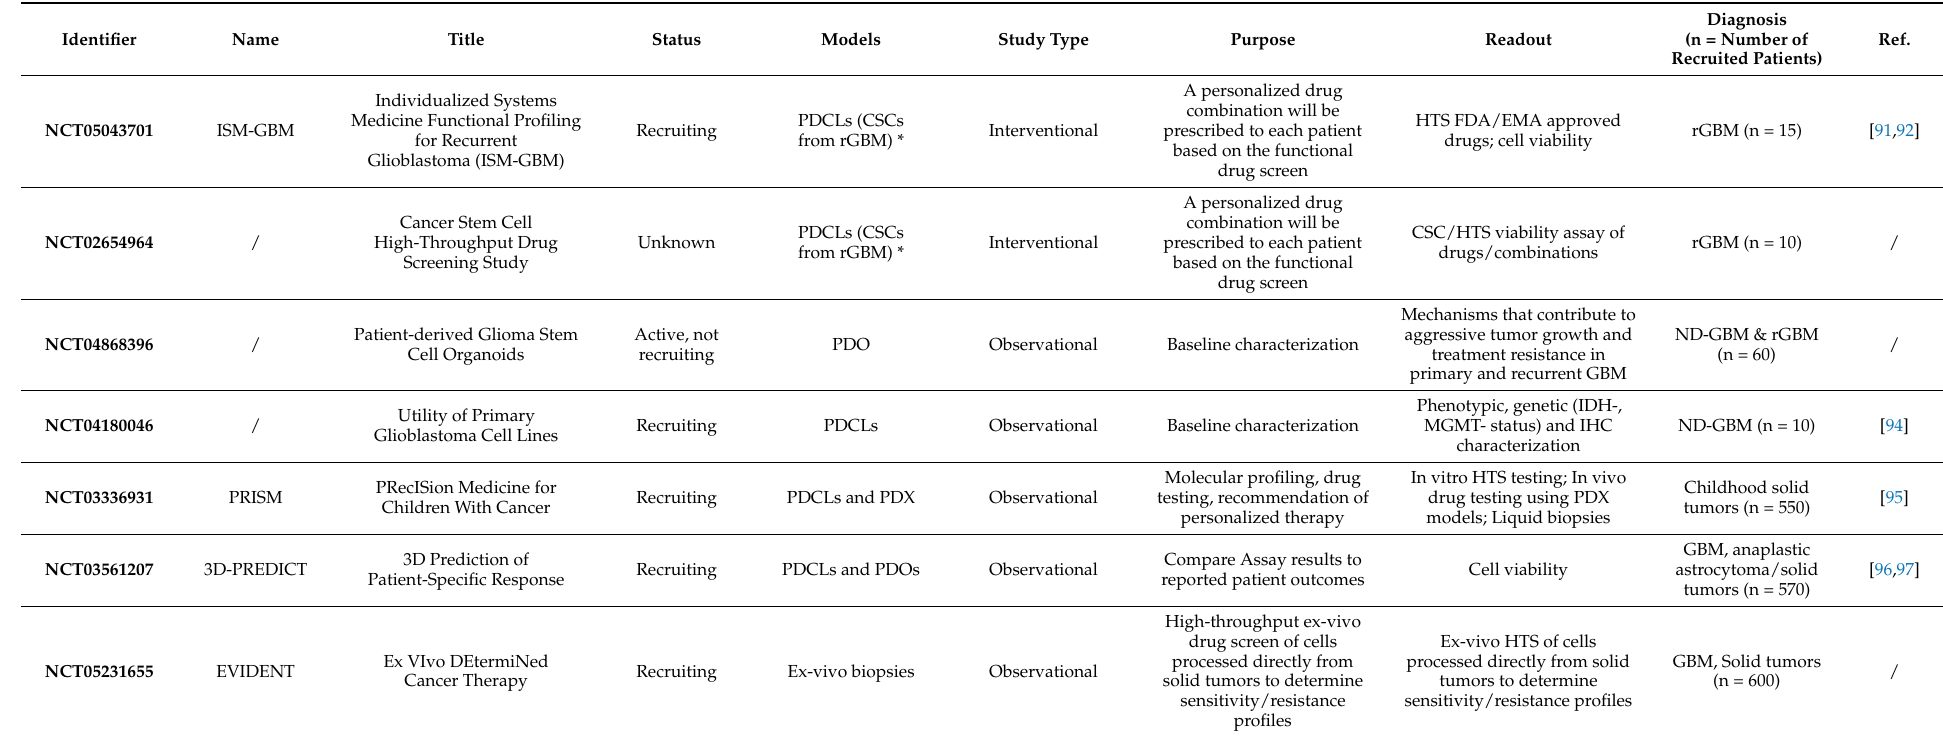
Table 1. Clinical trials in GBM using functional diagnostic